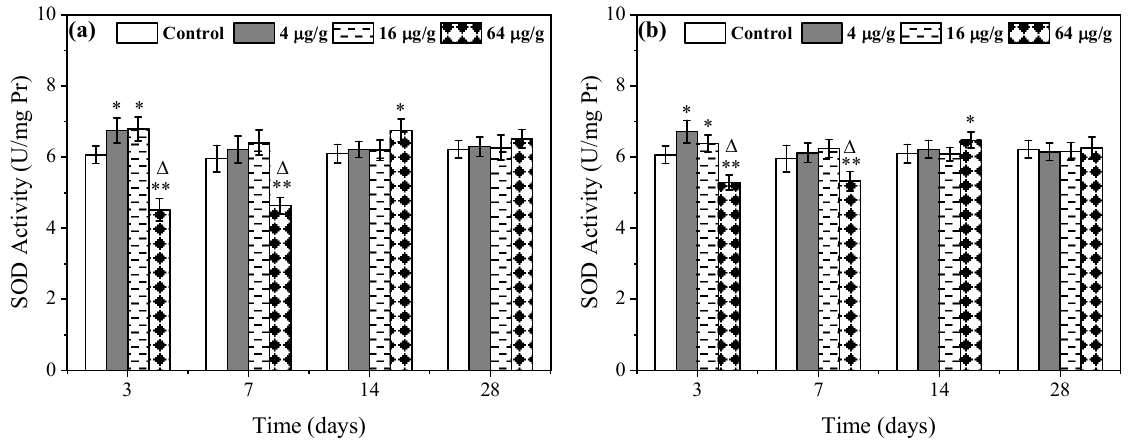
Figure 2. Effects of Rac - ( a ) and S -metolachlor ( b ) on SOD activity in E. fetida . * p < 0.05 and ** p < 0.01 indicate the statistical significance between the control group and treatment group at the same exposure time. “Δ” represents a significant difference between Rac - and S -metolachlor treatment groups at the same exposure concentration ( p < 0.05).